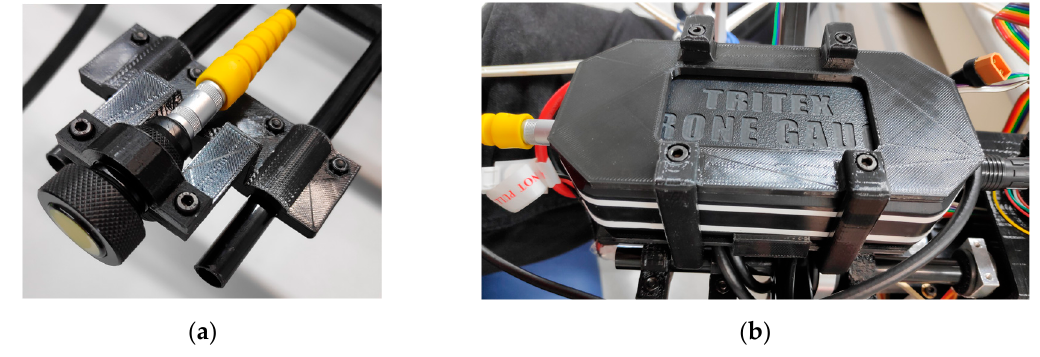
Figure 3. Components of the gauge. ( a ) Probe. ( b ) Gauge body.